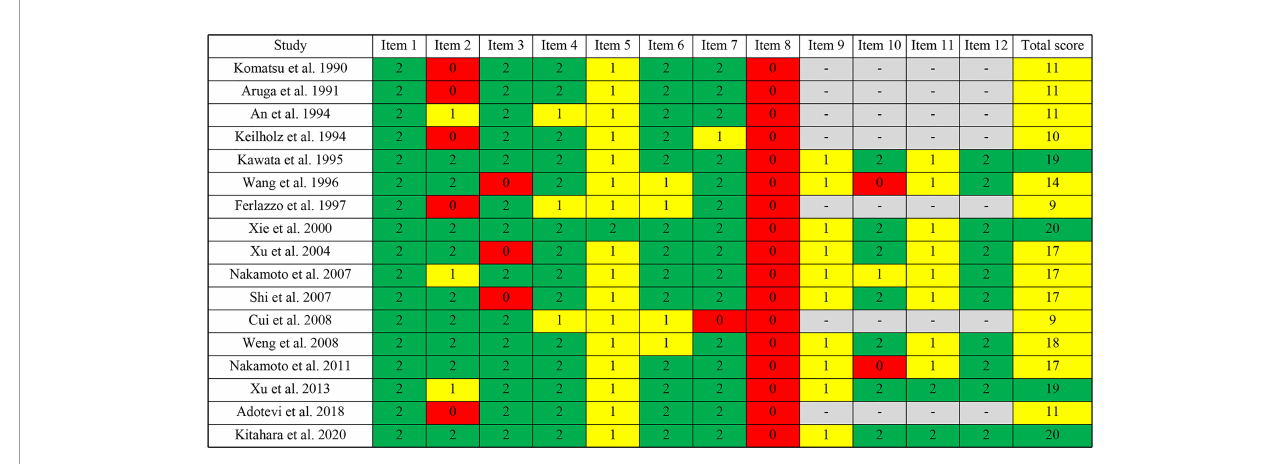
FIGURE 2 | Risk of bias in each study assessed using the MINORS tool.